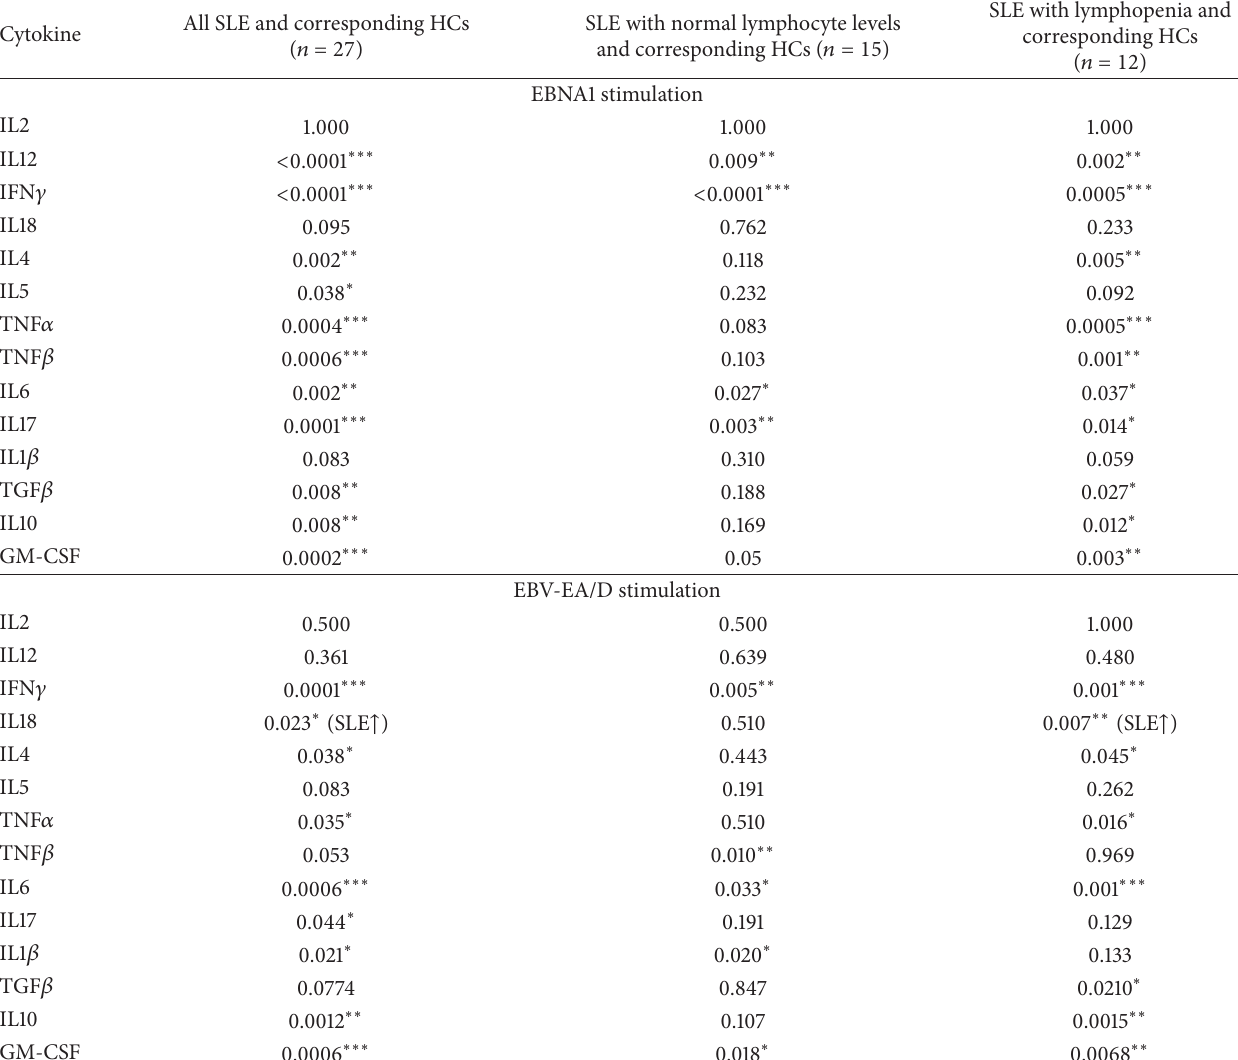
Table 5: 𝑝 values for comparison of cytokine concentrations in SLE patients and HCs (cid:3) . SLE with lymphopenia and All SLE and corresponding HCs SLE with normal lymphocyte levels Cytokine corresponding HCs ( 𝑛 = 27 ) and corresponding HCs ( 𝑛 = 15 ) ( 𝑛 = 12 ) EBNA1 stimulation 1.000 1.000 1.000 0.009 ∗∗